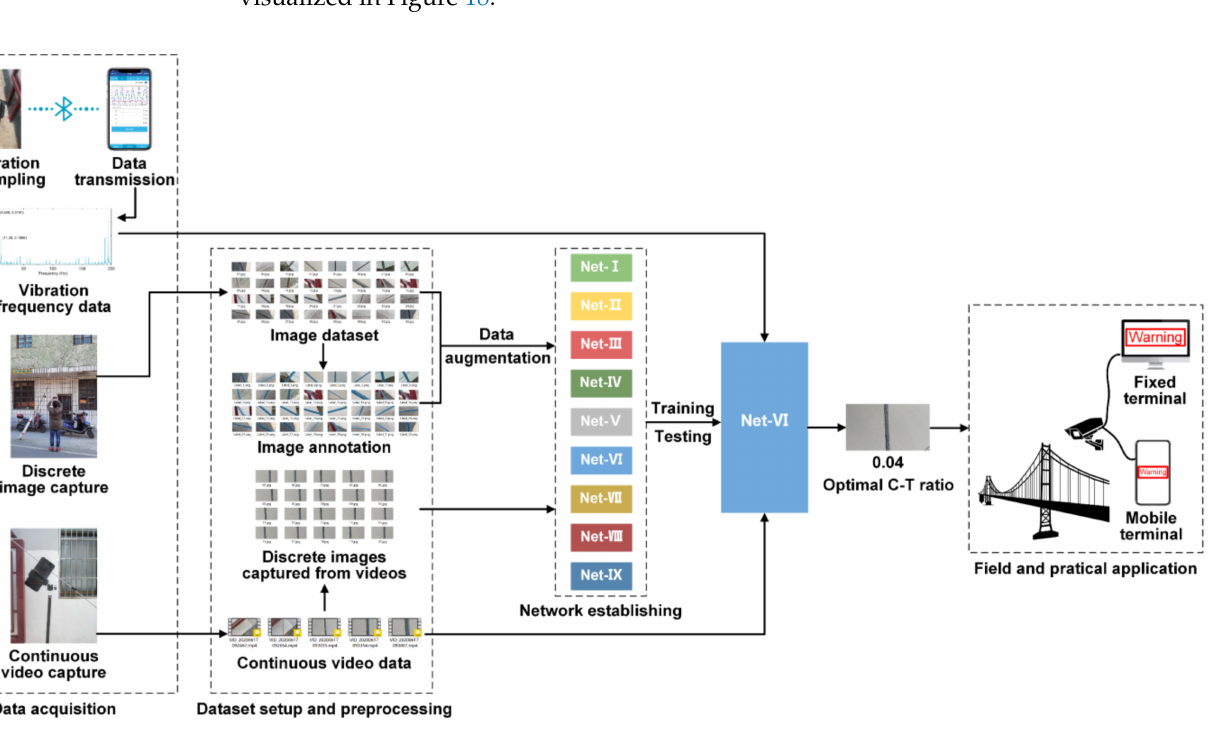
Figure 18. Working flow and research process of the present